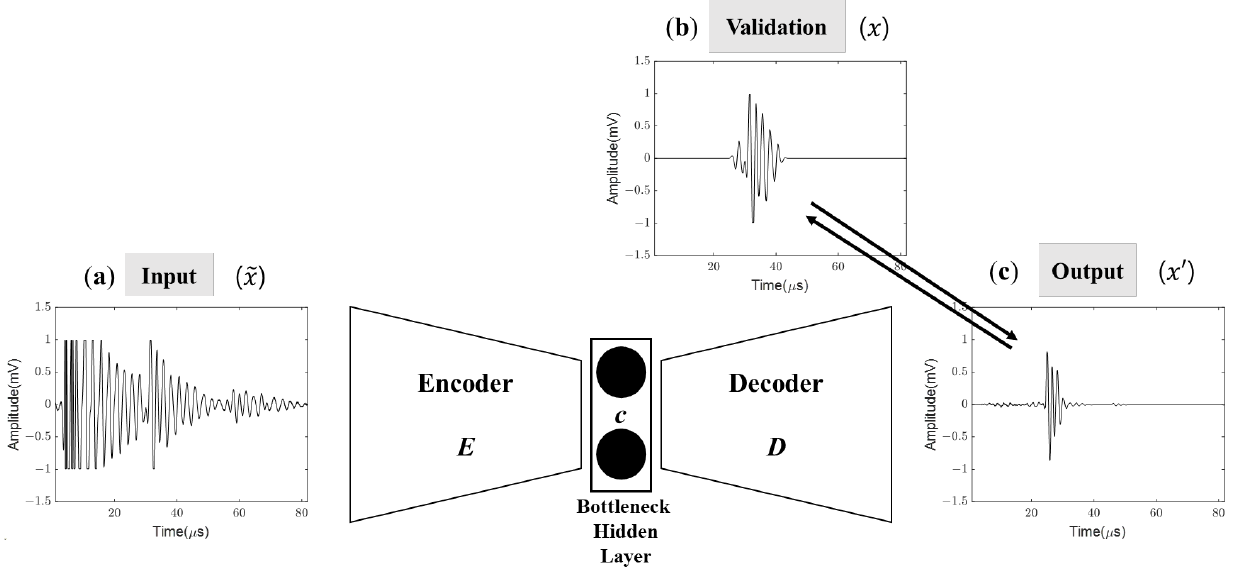
Figure 6. The architecture of proposed denoising autoencoder in this study: ( a ) The input or 𝑥̃ used in this study where it goes through the denoising autoencoder and its features are saved in the bottleneck hidden layer; ( b ) The flaw signal or 𝑥 that is used as validation where all of the extra signals beside the flaw signal are zero-padded. The validation is used for the MSE calculation with the output; ( c ) The output or 𝑥′ that is reconstructed through the denoising autoencoder where it is compared to the validation signal and the autoencoder learns to extract the flaw signal.